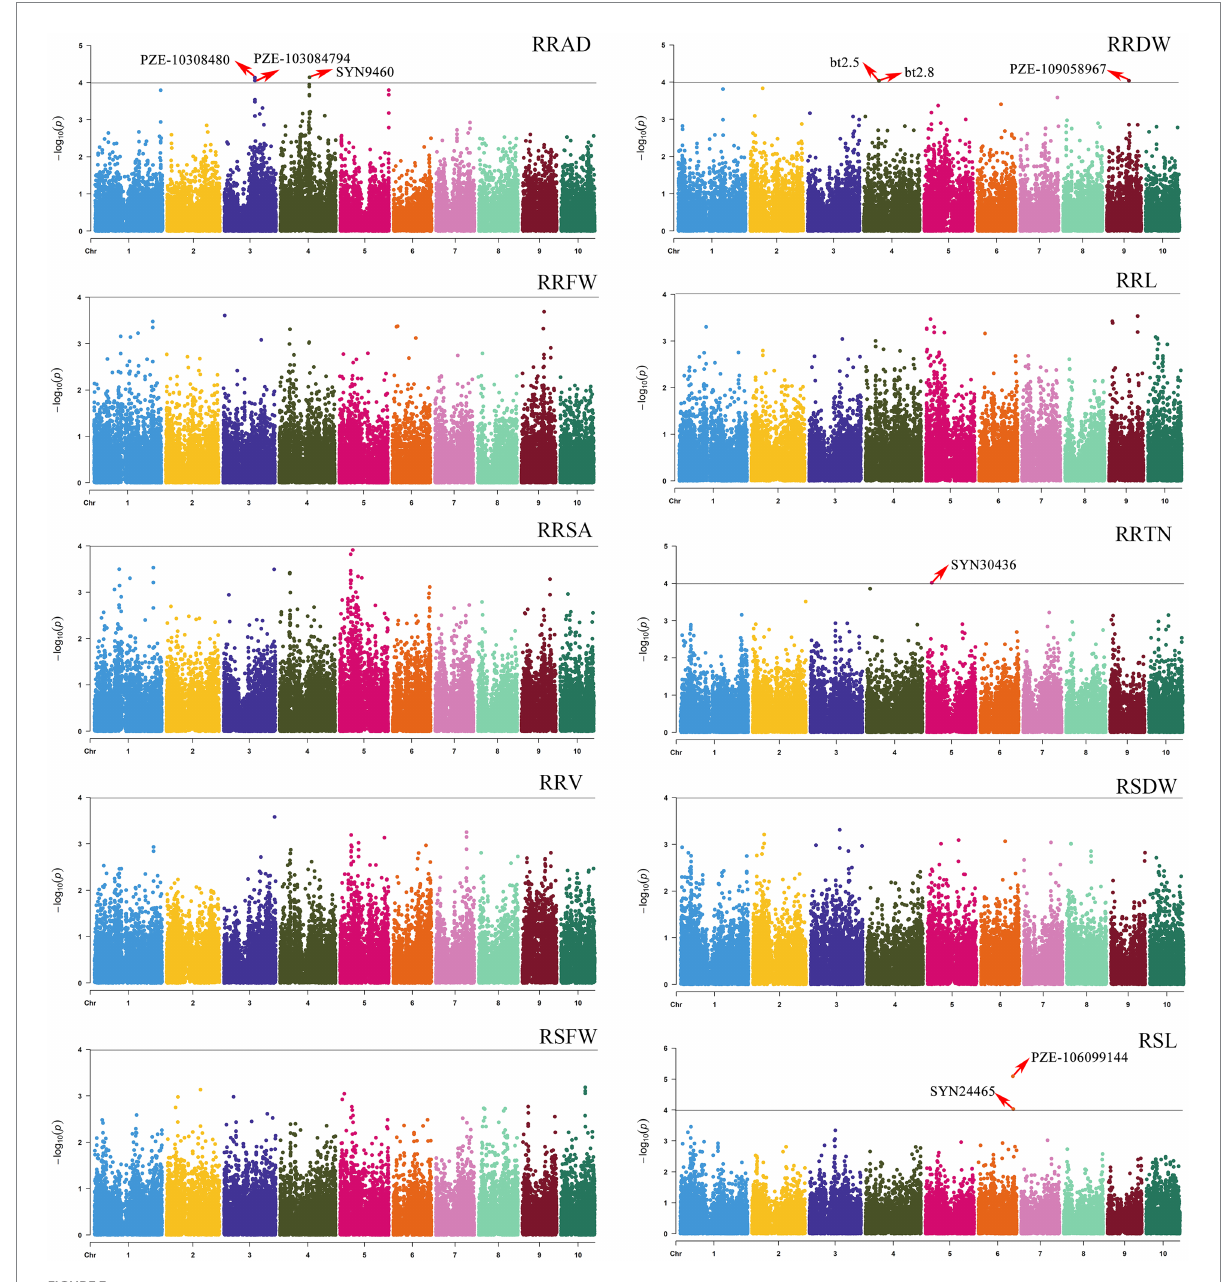
FIGURE 3 Manhattan plots of GWAS results showing the significant SNPs associated with 10 relative phenotypic traits. The traits included the following: the relative root average diameter (RRAD), relative root fresh weight (RRFW), relative root surface area (RRSA), relative root volume (RRV), relative shoot fresh weight (RSFW), relative root dry weight (RRDW), relative root length (RRL), relative root tip number (RRTN), relative shoot dry weight (RSDW), and relative seeding length